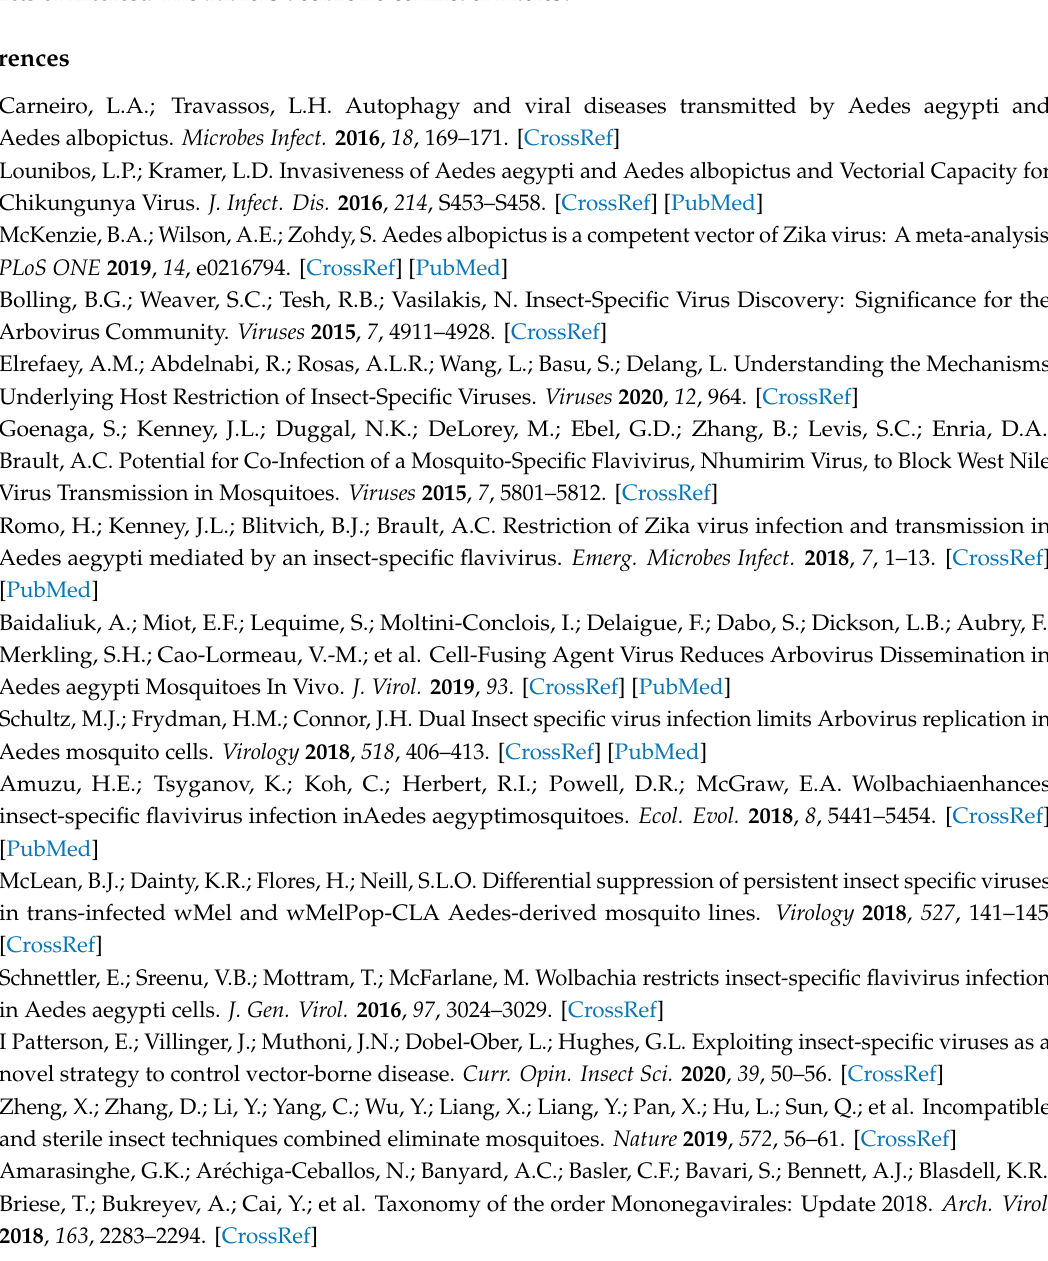
Figure S1: Distribution and mapping profiles of AealbAV-specific miRNAs in small RNA libraries of Ae. albopictus samples infected with CHIKV, Table S1: Mapping statistics and details of the sequencing libraries positive for AealbAV, Table S2: Putative anphevirus-like NIRVs in Ae. Albopictus